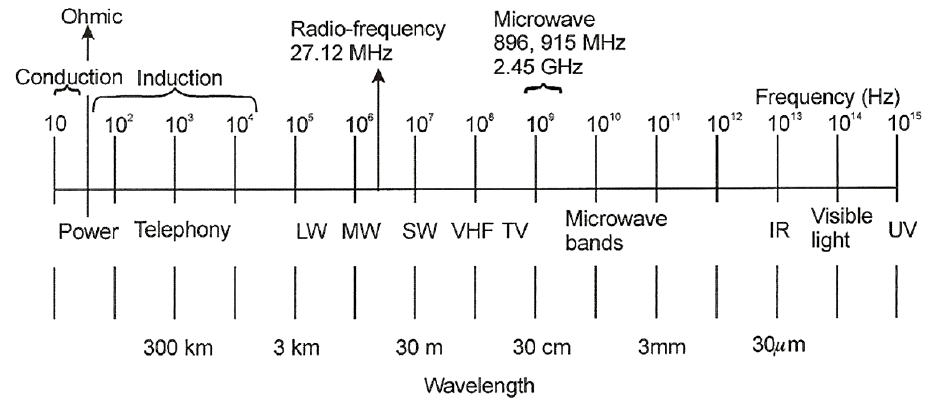
Figure 1. Typical electromagnetic spectrum with examples of applications performed at different frequency ranges